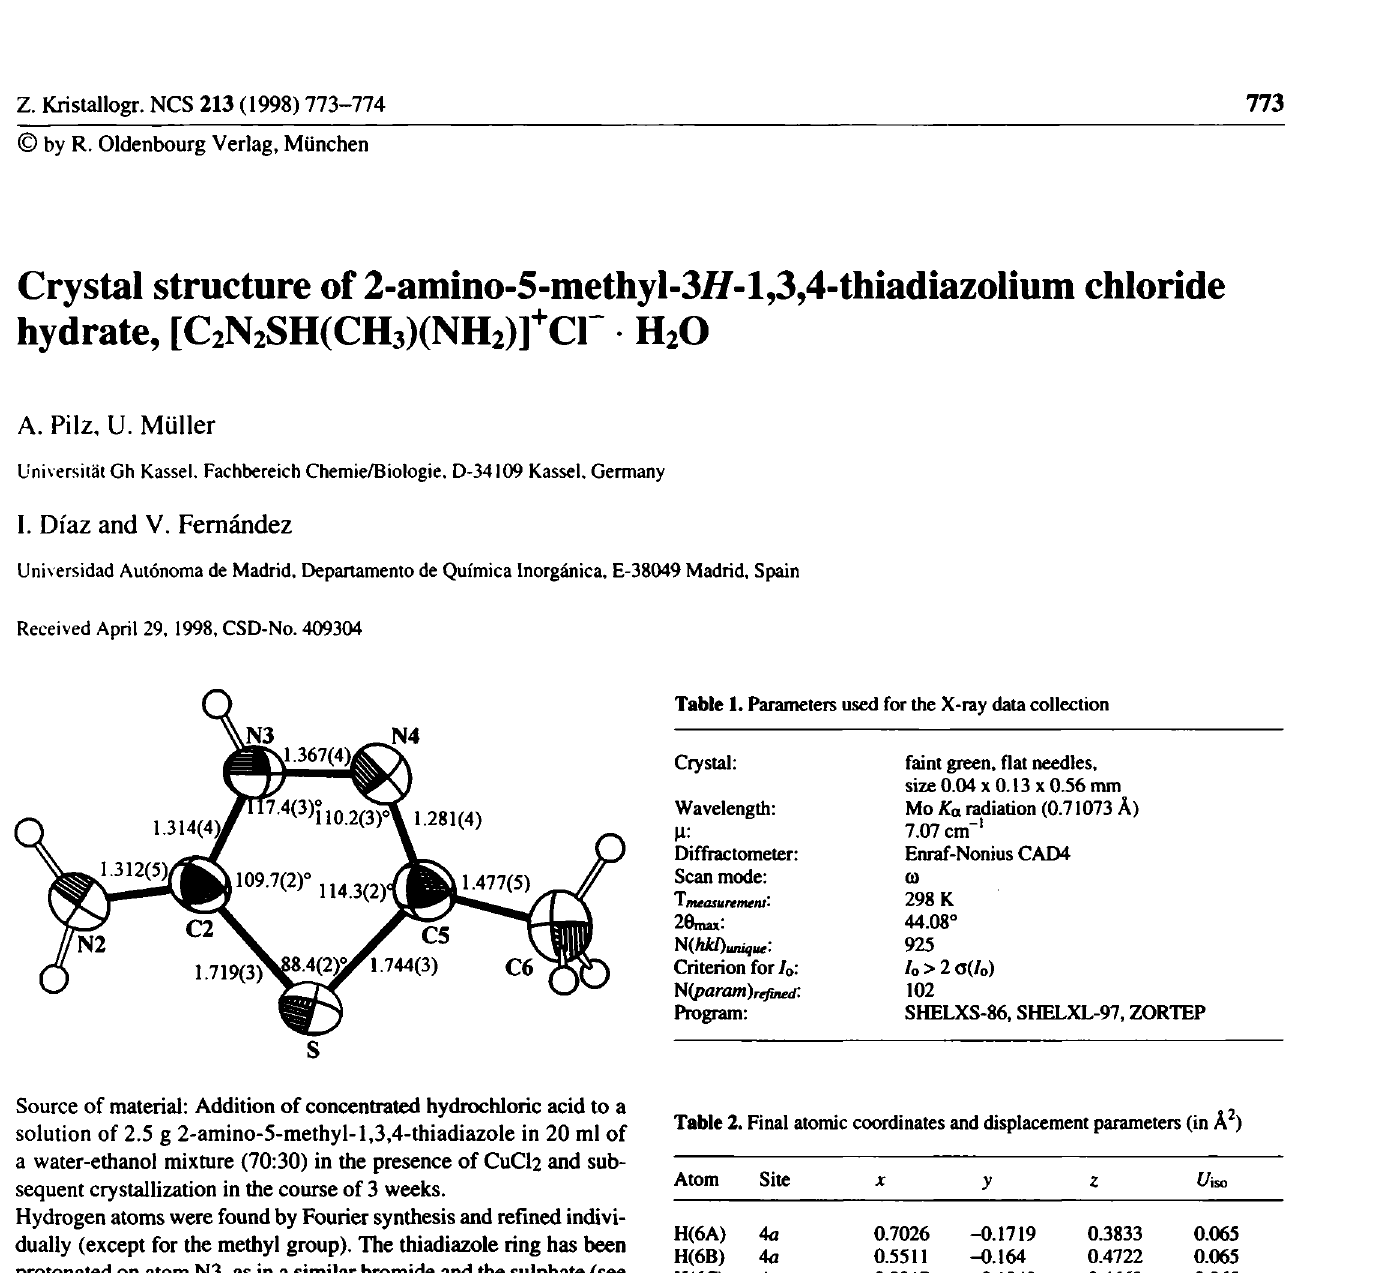
Table 3. Final atomic coordinates and displacement parameters (in Â^)